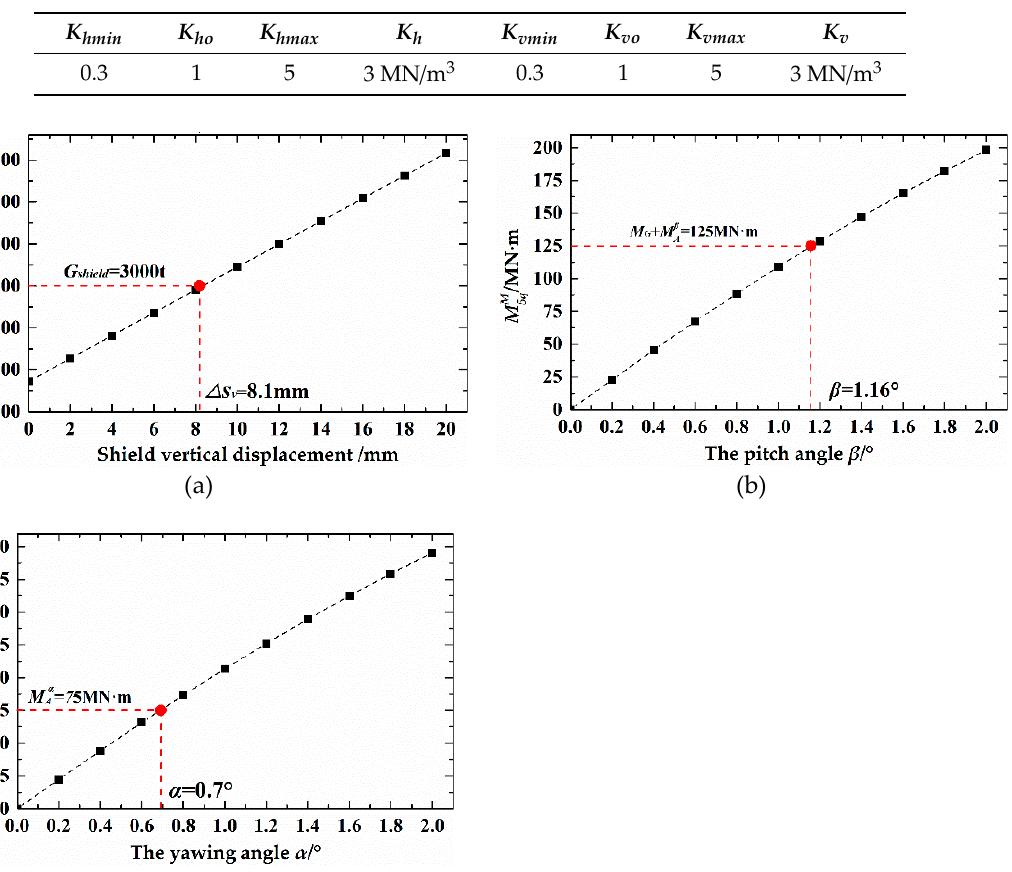
Table 1. Ground reaction curve coefficient table [11].